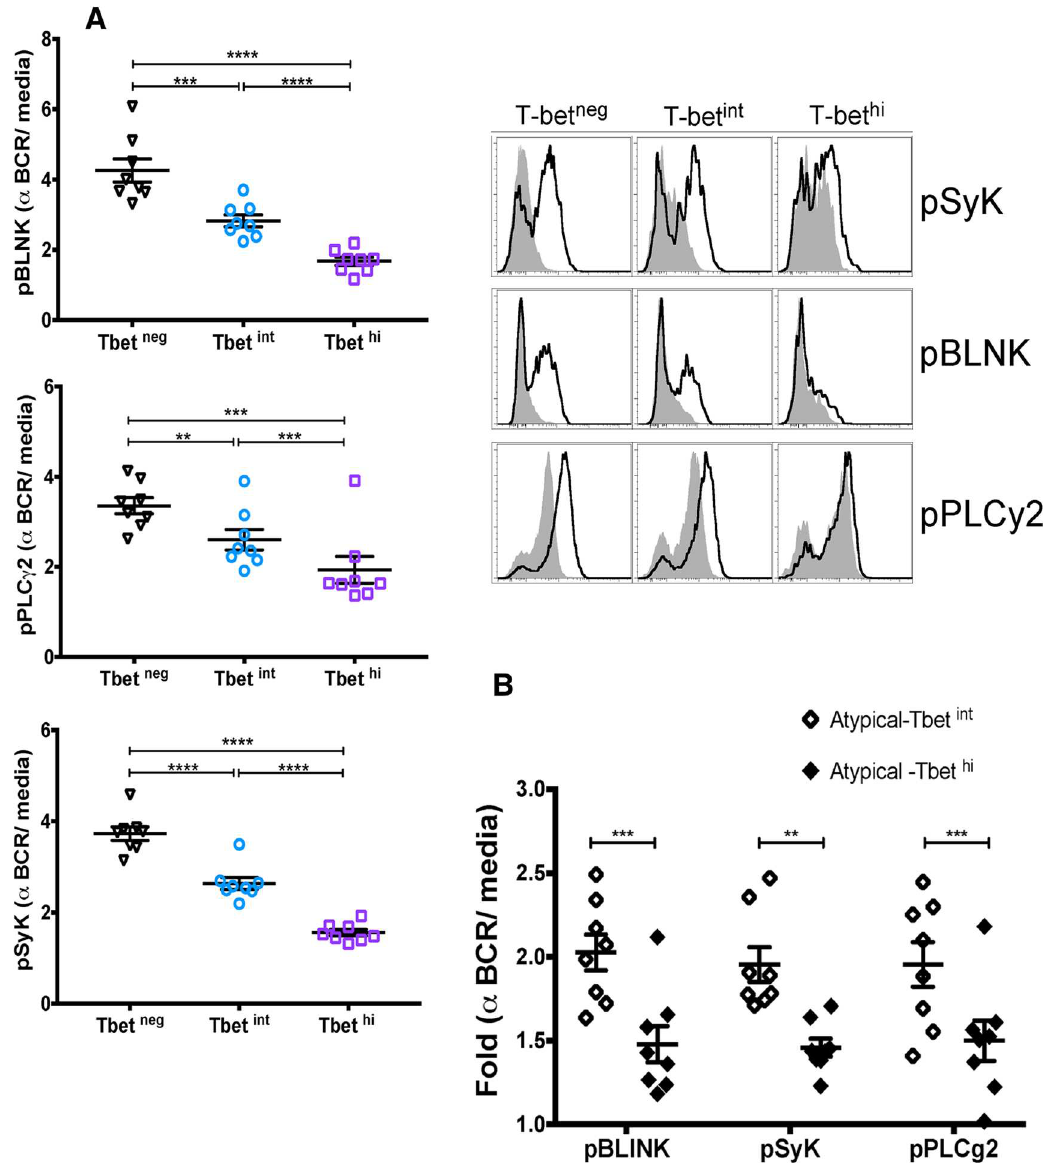
Fig 5. T-bet hi atypical MBCs of malaria-exposed children exhibit reduced BCR signaling. ( A ) Ratio of phosphorylated Syk, BLNK, and PLC γ 2followingBCR cross-linking over baselinefluorescence in negatively sorted B cells (n = 8 Malianchildren;representative subject, right). ( B ) MFI of pBLNK, pSyk and pPLC γ 2in T-bet int and T-bet hi atypical MBCs after BCR cross-linking (n = 8 Malianchildren).p values determinedby pairedStudent’s t test with Bonferroni corrections for multiplecomparisons where appropriate. **** P < 0.0001, *** P < 0.001, ** P < 0.01, * P < 0.05, ns = not